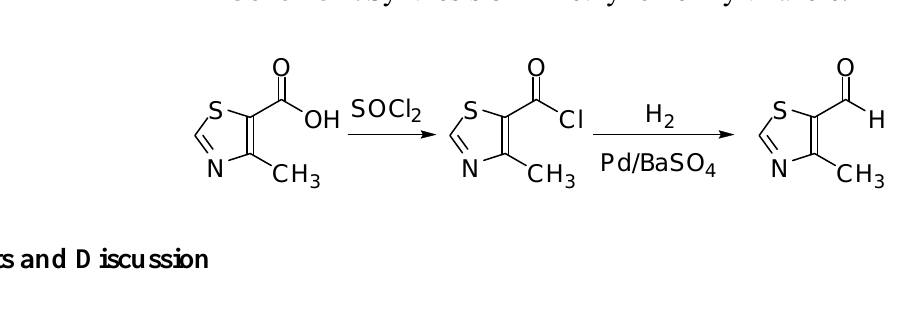
Scheme 1. Synthesis of 4-methyl-5-formylthiazole.